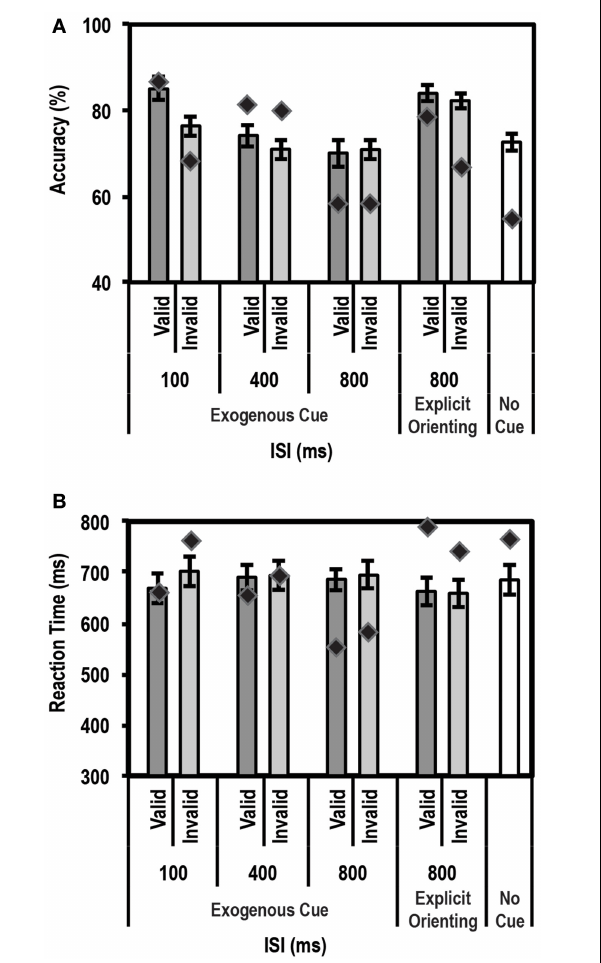
FIGURE 6 | Average accuracy (A) and reaction time (RT) data (B) for age-matched controls ( N = 10) and the patient for the Exogenous Cueing Task with Explicit Reorienting. Dark gray bars represent performance on validly cued trials. Light gray bars represent performance on invalidly cued trials. Unshaded bar shows performance on No-Cue trials. Errors represent standard error of the mean for the control group. Diamond markers indicate performance of the patient. The patient was as accurate as controls on all trial types but showed faster RTs for the implicitly cued 800ms ISI condition. When explicitly cued during the long 800ms ISI, the patient’s RT data did not differ from controls.